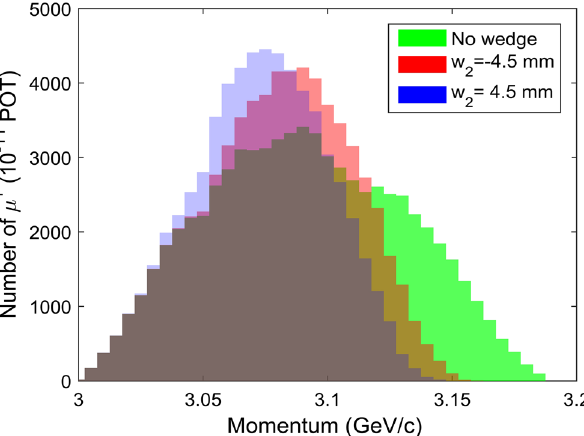
FIG. 11. Momentum distribution at the end of M5. With green we show the case without an absorber while with red and blue we show the distributions for different offsets of W 2 . The apex of W 1 is fixed at the beam line center.